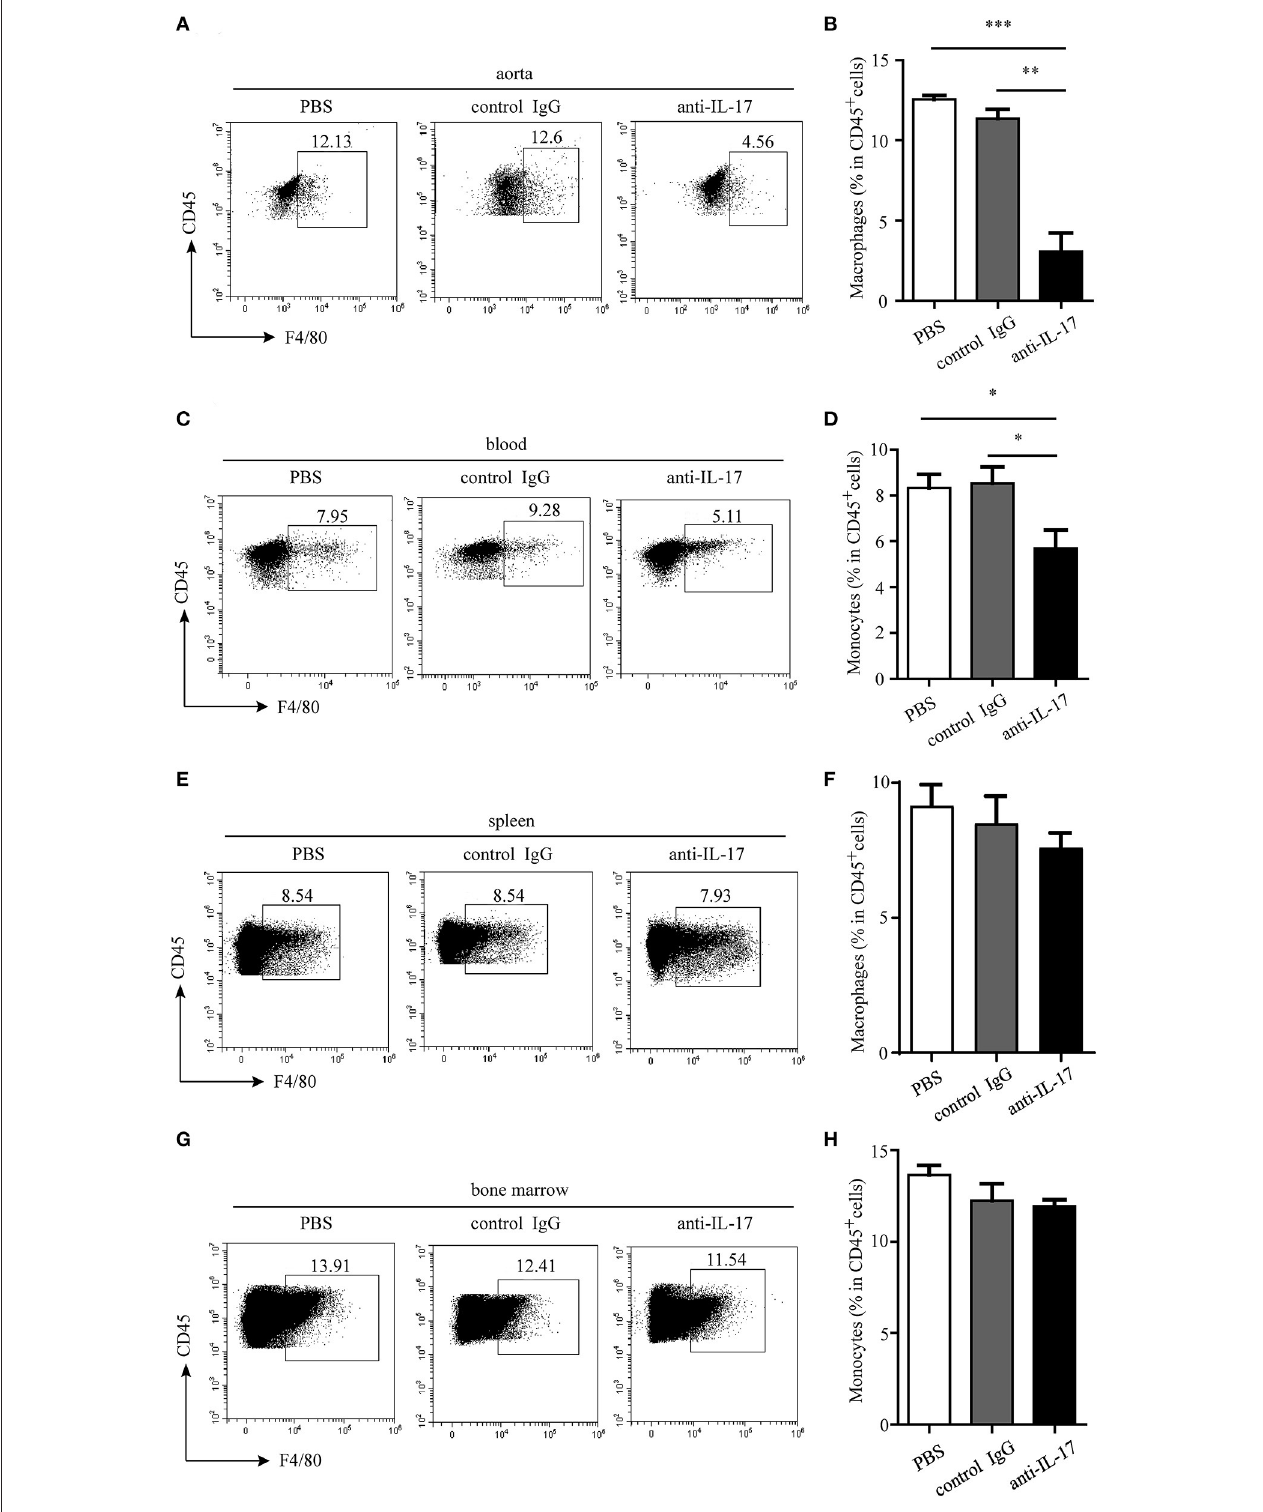
FIGURE 5 | Monocyte/macrophage infiltration in different organs after IL-17 blocking. Representative dot plots of monocyte/macrophage gating on CD45 + leukocytes and quantitative analysis of monocyte/macrophage percentages in (A,B) aorta, (C,D) blood, (E,F) spleen, and (G,H) bone marrow. * p < 0.05, ** p < 0.01, *** p <